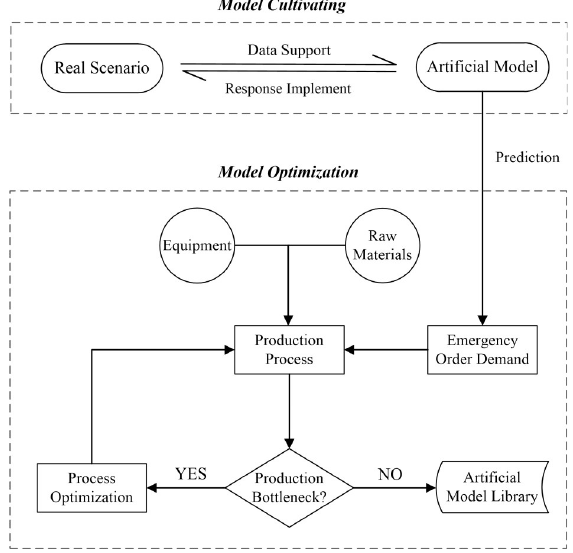
Fig 1. Parallel simulation and optimization framework based on